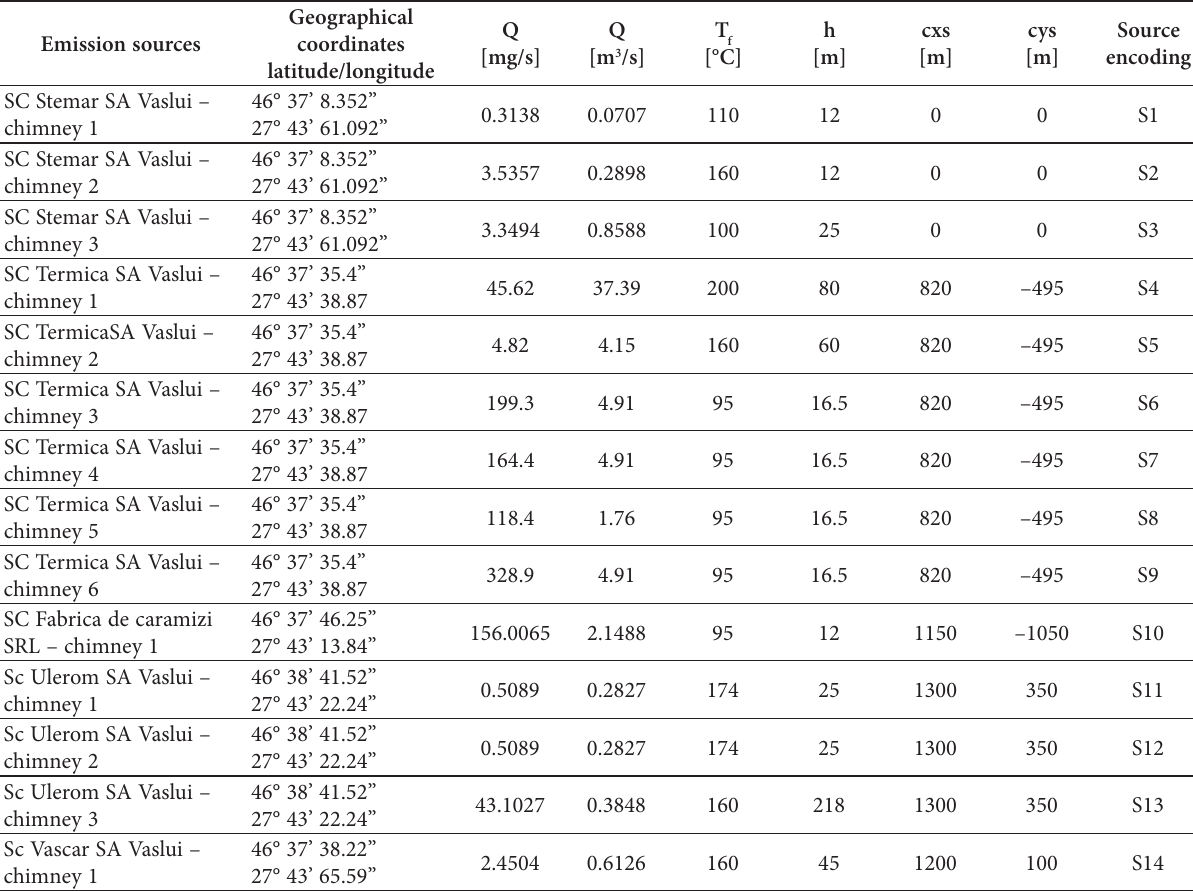
Table 2. Input data – emission sources for Pol 15sm